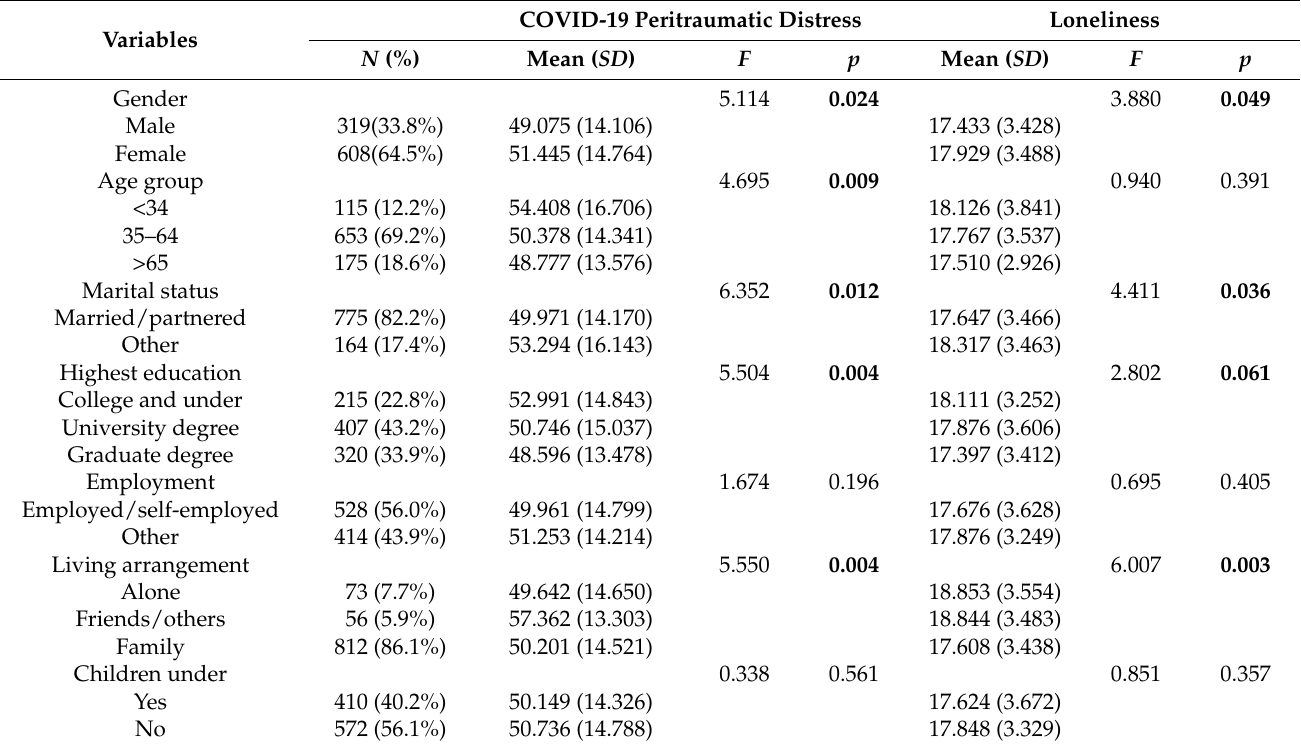
Table 1. Sample characteristics and their relationships with COVID-19 peritraumatic distress and loneliness ( N =